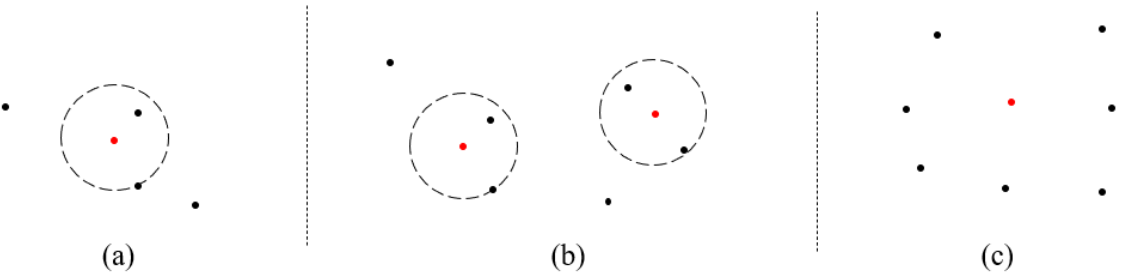
Figure 2. Examples of One-Class DBSCAN